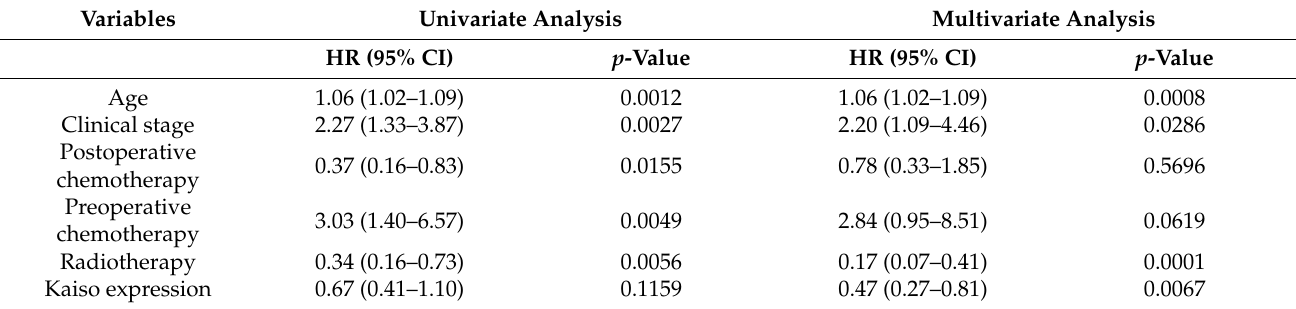
Figure 6. Overall survival (OS) in the whole group. 4. Discussion TNBCs are classified histologically as invasive mammary carcinomas of no specific type that lack distinctive histological characteristics [23]. Despite the identification of TNBC molecular subtypes [8], a correlation between the current clinical therapeutic strat- egies and the histological and molecular complexity of TNBC has not been found [23]. In the past decades, comprehensive research efforts have been put into finding new predictive molecular markers for the development of diagnostic and therapeutic methods in breast cancer. In this regard, several antigens, e.g., BRCA1, BRCA2, BR 27.29, CA 15-3, CA 27.29, CEA, c-myc, HER-2/neu, MUC-1, or p53 have been reported for monitoring breast cancer progression [24]. The subject of our study—Kaiso transcription factor—did not fall into the molecular markers list for TNBC patients yet. However, it has demonstrated al- terations in Kaiso expression in this subtype of breast cancer. To address this topic, we per- formed a comprehensive evaluation of mRNA and protein Kaiso expression in publicly avail- able databases and using tissue microarray techniques in TNBC samples, respectively. According to GDC Data Portal OS and PFI in the TCGA, TNBCs cohorts were signif- icantly decreased for advanced clinical stages, which corresponds to previously published results [19]. However, we did not observe any significant relationship between OS or PFI